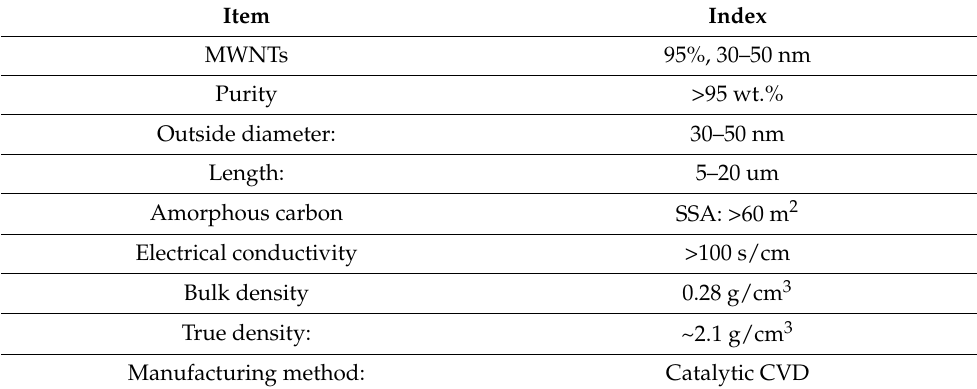
Table A1. Thermal properties of paraffin and used nanoparticles.